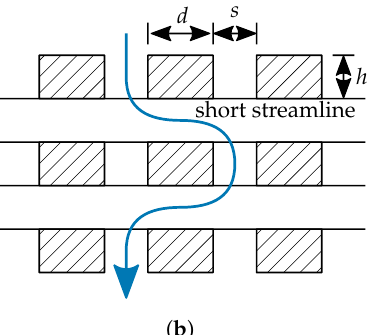
Figure 6. An illustration of how the bar width could effect tortuosity. The bar width d is changed; bar height h and spacing s remain unchanged. The blue arrows show a possible streamline of a fluid particle. The length of the streamline positively correlates with the apparent tortuosity. ( a ) Fluid streamline for a large bar width and thus rather long streamline. ( b ) Fluid streamline for a small bar width, and thus, rather short